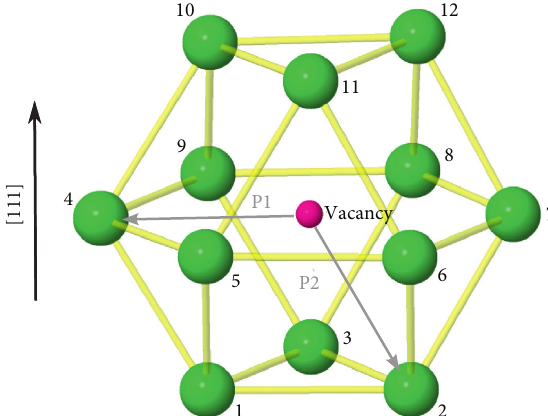
Figure 1: (111) planes in pure Ni. The in-plane (P1) and out-of- plane (P2) migration paths for a vacancy at the center of the fcc Ni. The green spheres represent the atoms on the adjacent lattice points, while the central sphere represents the